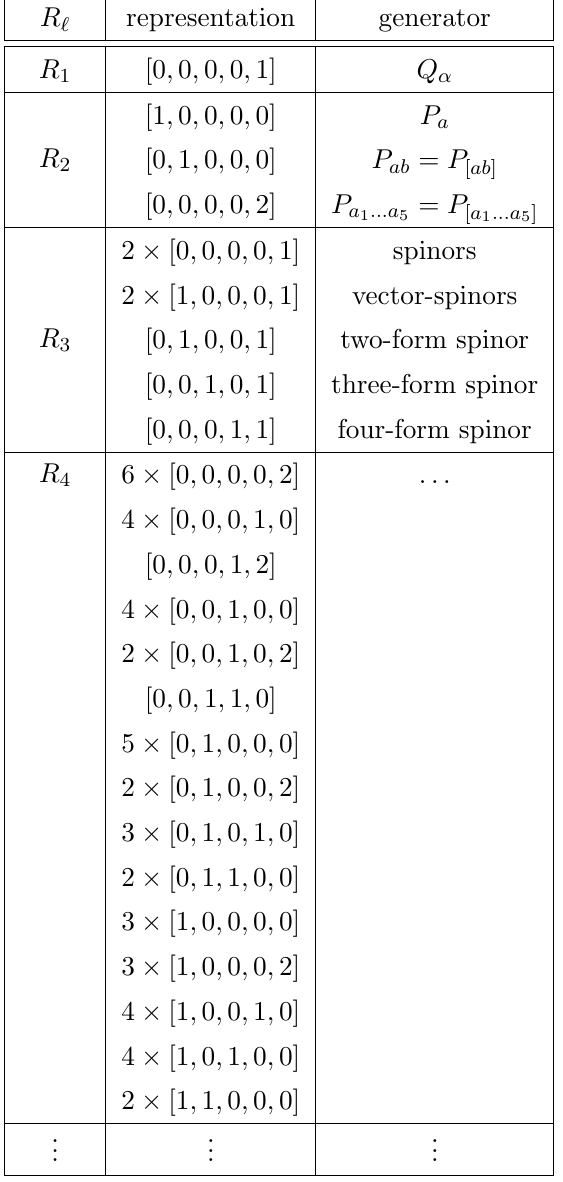
Table 4 . The free Lie superalgebra f ( Q ) in D = 11 space-time dimensions for a single 32- component spinor generator Q (cid:11) . All so (1 ; 10) representations are labelled by their B 5 Dynkin labels in Bourbaki numbering. Tensor-spinors are gamma traceless but we retain tensor traces. Some representations occur with multiplicity as shown. Lie algebra B . The last label refers to the spinor node of the B 5